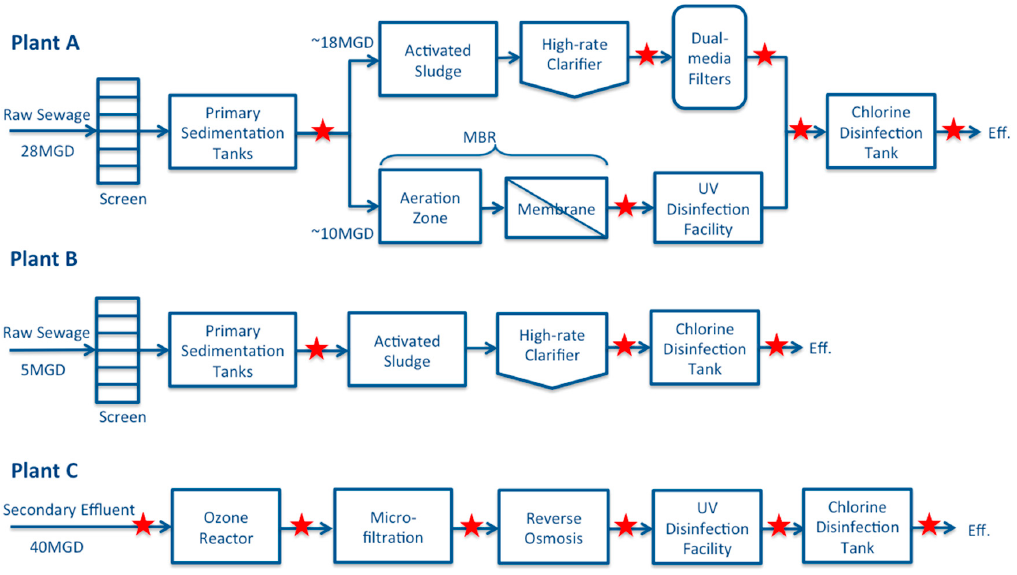
Figure 1. Schematic of unit treatment processes at three water reclamation plants sampled during this study. Star indicates the sampling locations along the treatment trains.